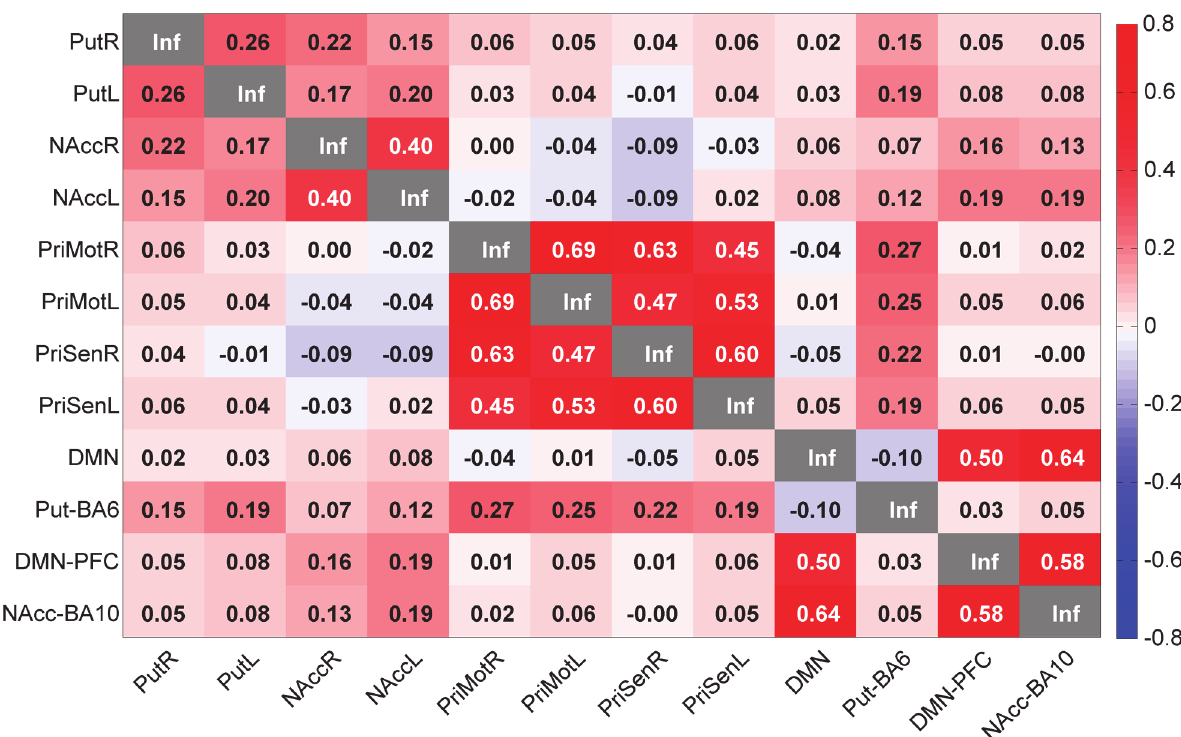
Fig 9. Human Seed Correlation Matrix. Note the high correlations between the somatosensory and motor regions as well as the high correlations between the prefrontal regions of the brain. Put = Putamen, NAcc = Nucleus Accumbens, PriMot = Primary Motor Cortex, PriSen = Primary Sensory Cortex, DMN = Posterior Cingulate Cortex, Put-BA6 = Brodmann Area 6 within the Putamen network DMN-PFC = Prefrontal Cortex within the DMN, NAcc-BA10 = Brodmann Area 10 within the ventral basal ganglia network. The values displayed are Fisher z-transformed correlation values.